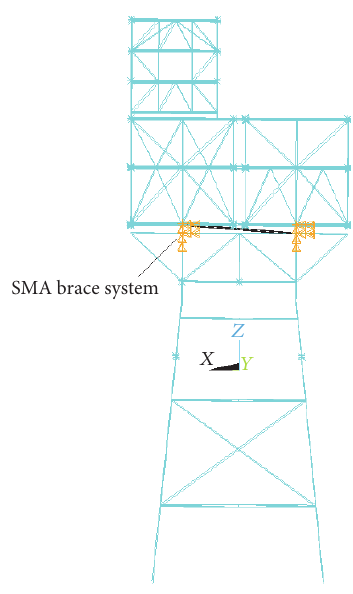
Figure 5: FEM of structure with SMA brace